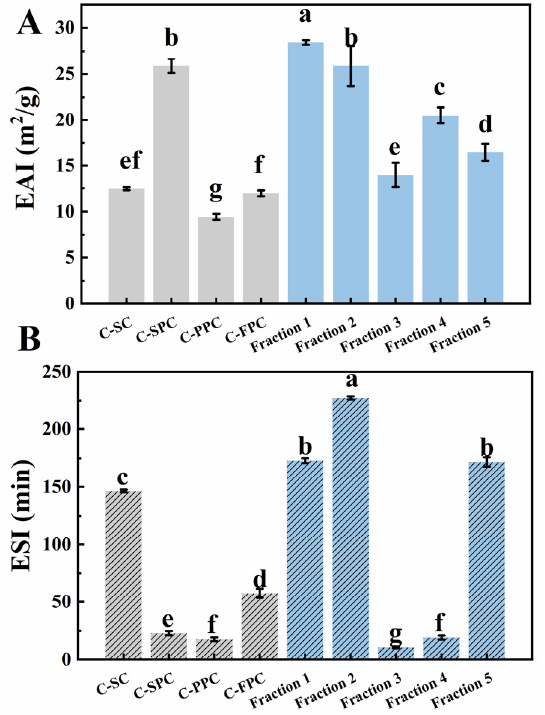
Figure 5. EAI ( A ) and ESI ( B ) of flaxseed protein-polysaccharide natural fractions, C-SC, C-SPC, C-PPC, and C-FPC. EAI and ESI represent the emulsifying activity index and emulsifying stability index, respectively. Comparisons were performed between values of the same serious and those without same letter(s) differed significantly at p < 0.05.